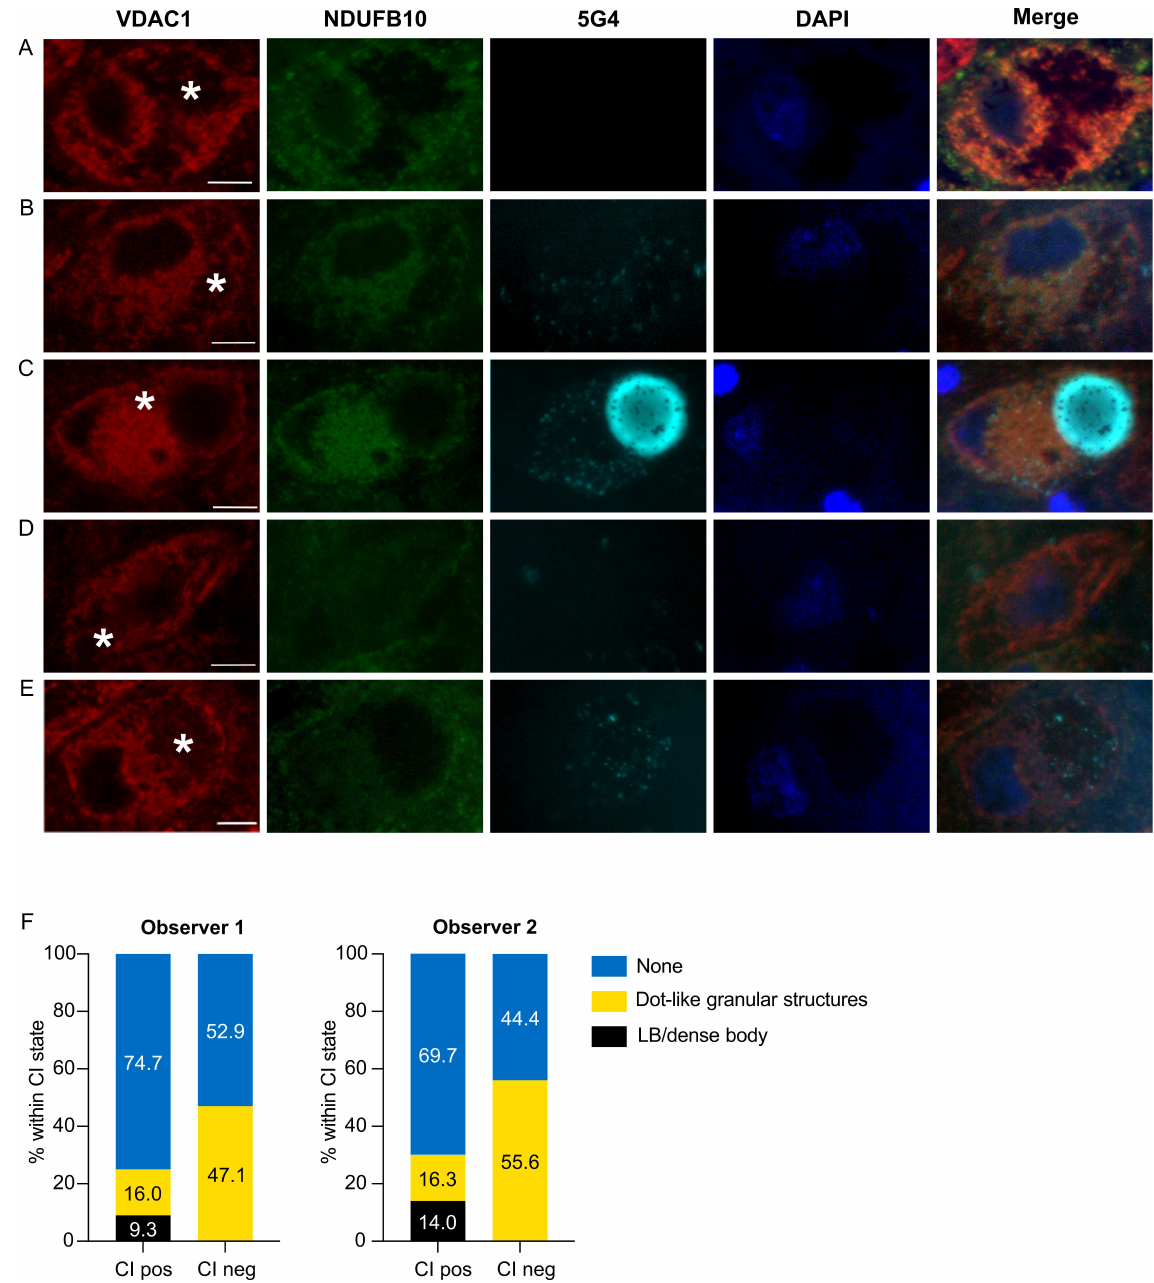
Figure 2. Immunofluorescence staining for CI and aggregated α -synuclein in dopaminergic neurons of the SNc. The images show representative examples of fluorescence immunoreactivity against the mitochondrial outer membrane marker (VDAC1, red), CI (NDUFB10, green), aggregated α -syn (5G4, cyan), dsDNA (DAPI, blue), and a combination of all channels. CI-positive neurons were either 5G4-negative ( A ), or 5G4-positive with punctate inclusions ( B ) or LB/PB ( C ). CI-negative neurons were either 5G4-negative ( D ), or positive with punctate inclusions ( E ). Neuromelanin is marked with an asterisk. Scale bar: 10 microns. The plots in ( F ) depict the total percentage of neurons in each α -syn inclusion state (LB or PB/punctate inclusions/no inclusion) within each CI state (positive/negative) from each of the